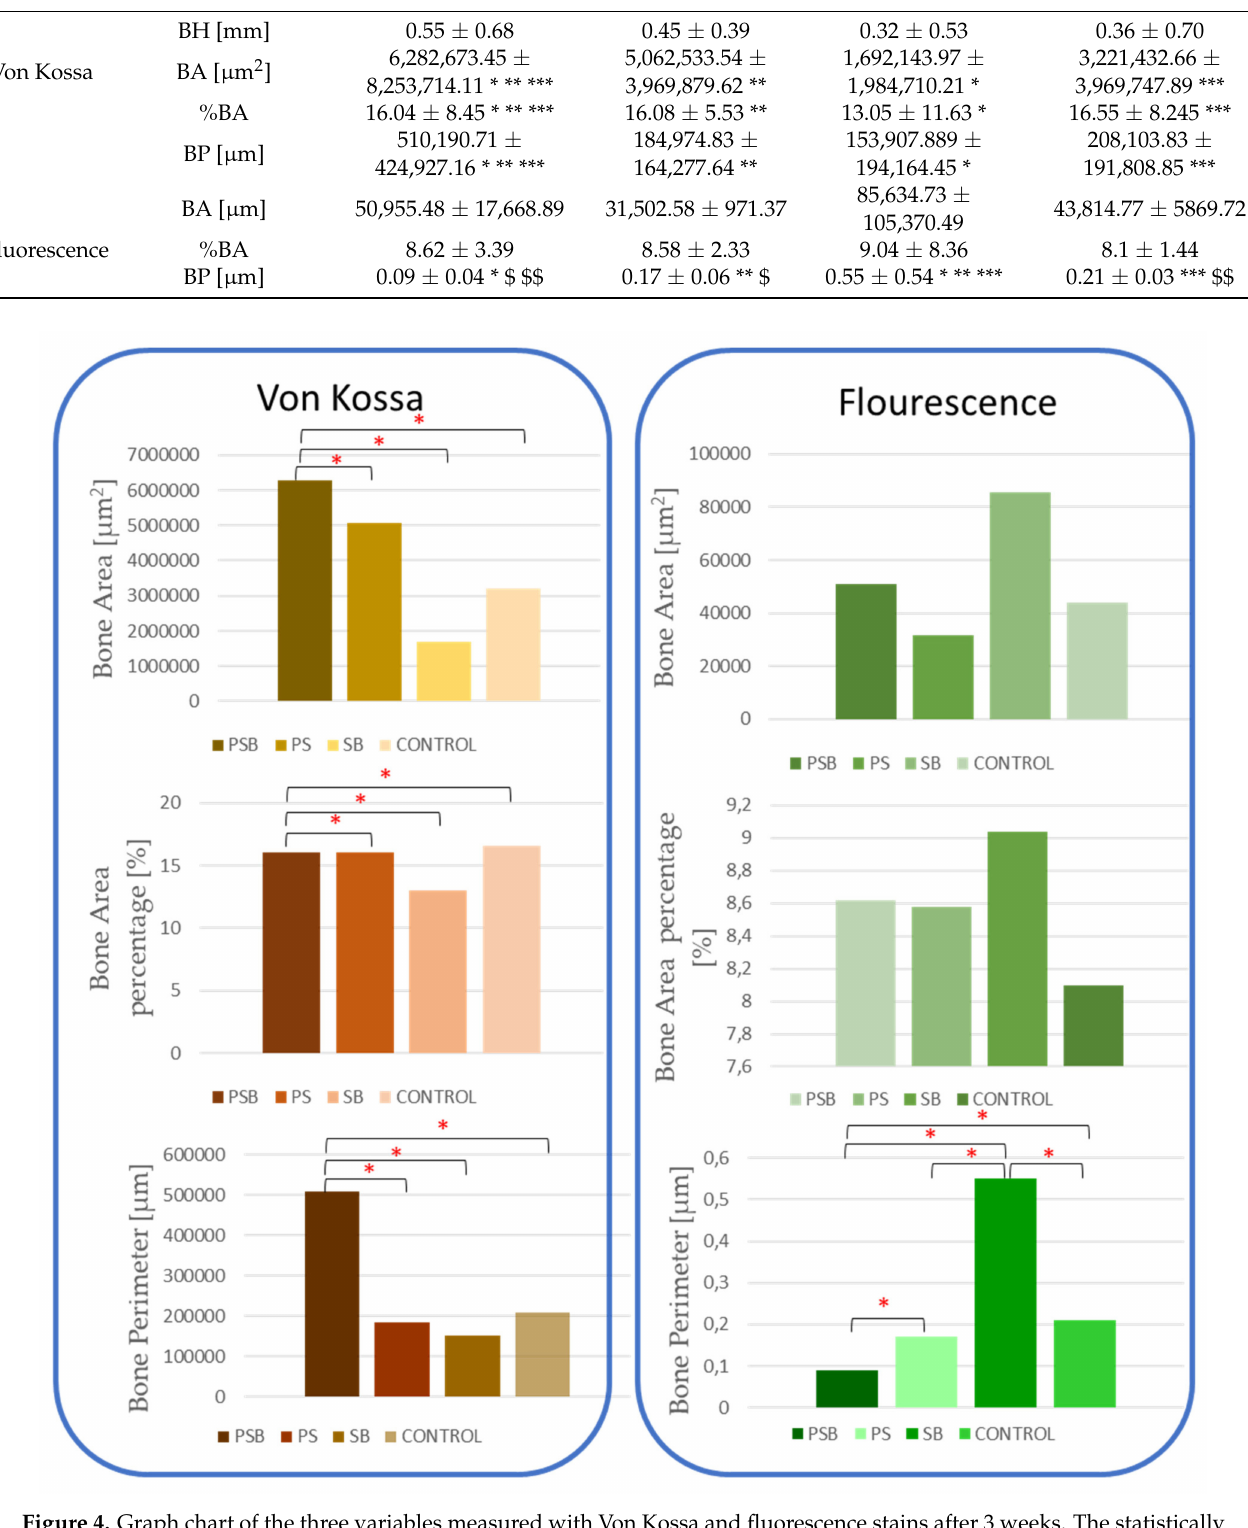
Figure 4. Graph chart of the three variables measured with Von Kossa and fluorescence stains after 3 weeks. The statistically significant differences between groups are shown with (*) symbol ( p <